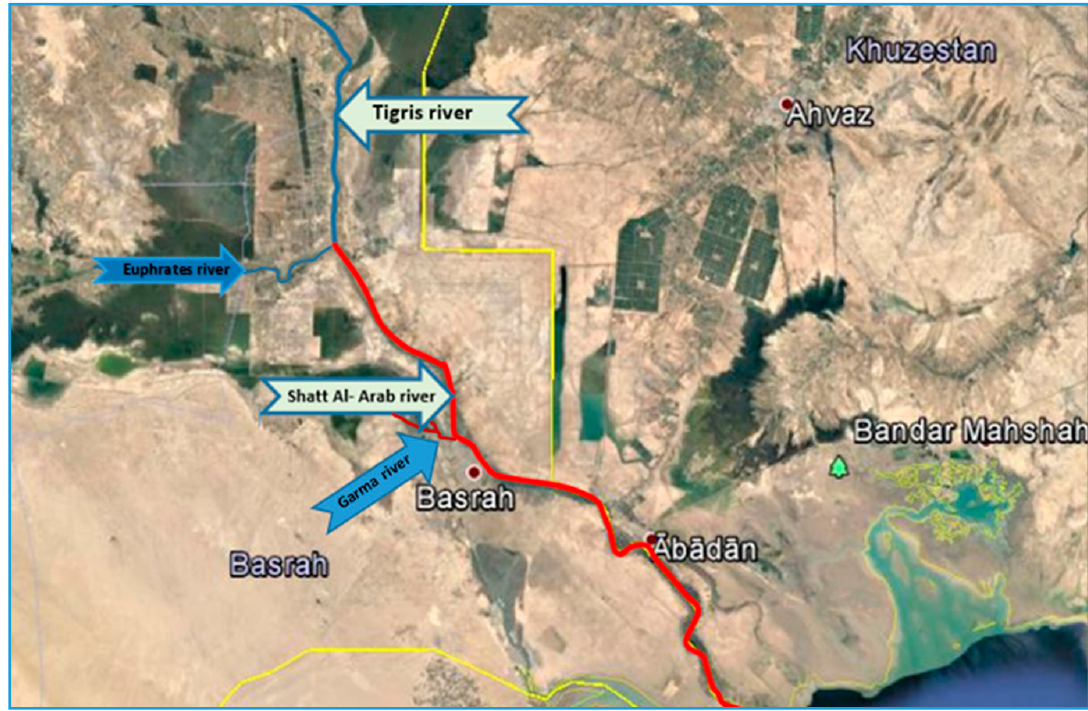
Figure 1. Shatt Al-Arab River and its tributaries.